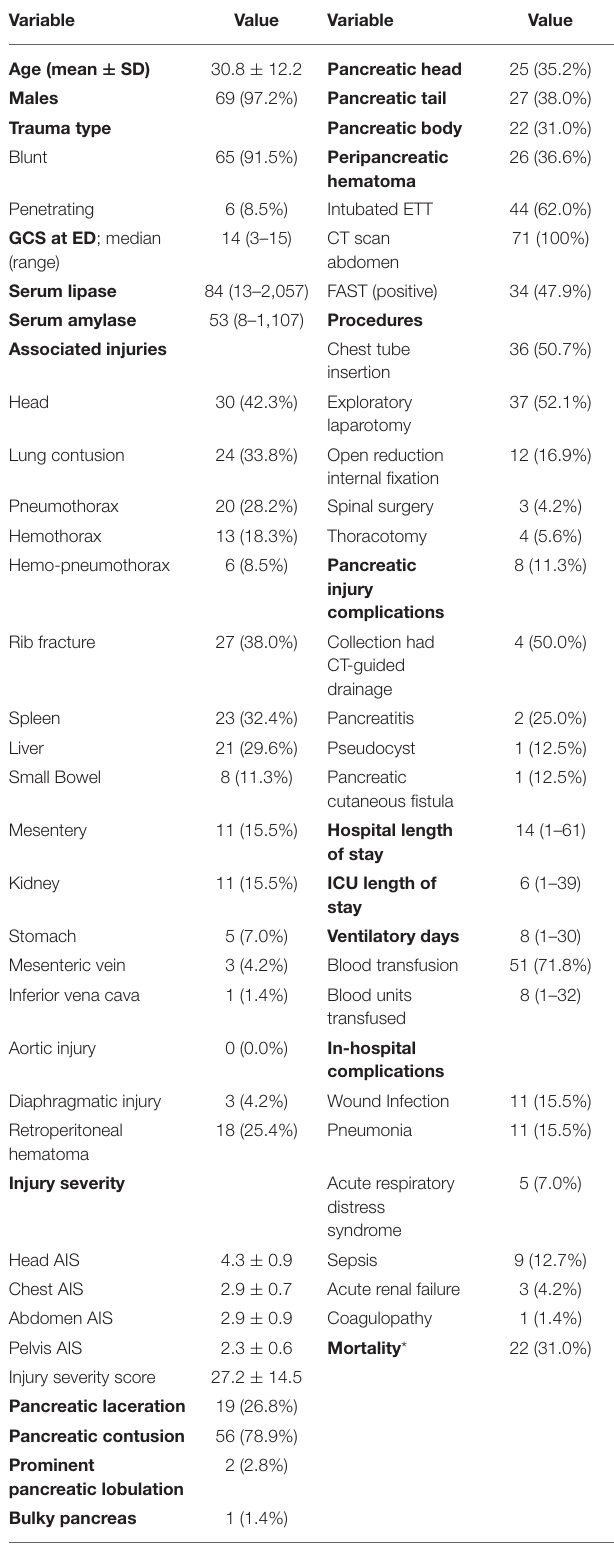
TABLE 1 | Demographics, clinical presentation, associated injuries, procedures, complications and outcomes in patients sustained pancreatic injury ( n = 71).